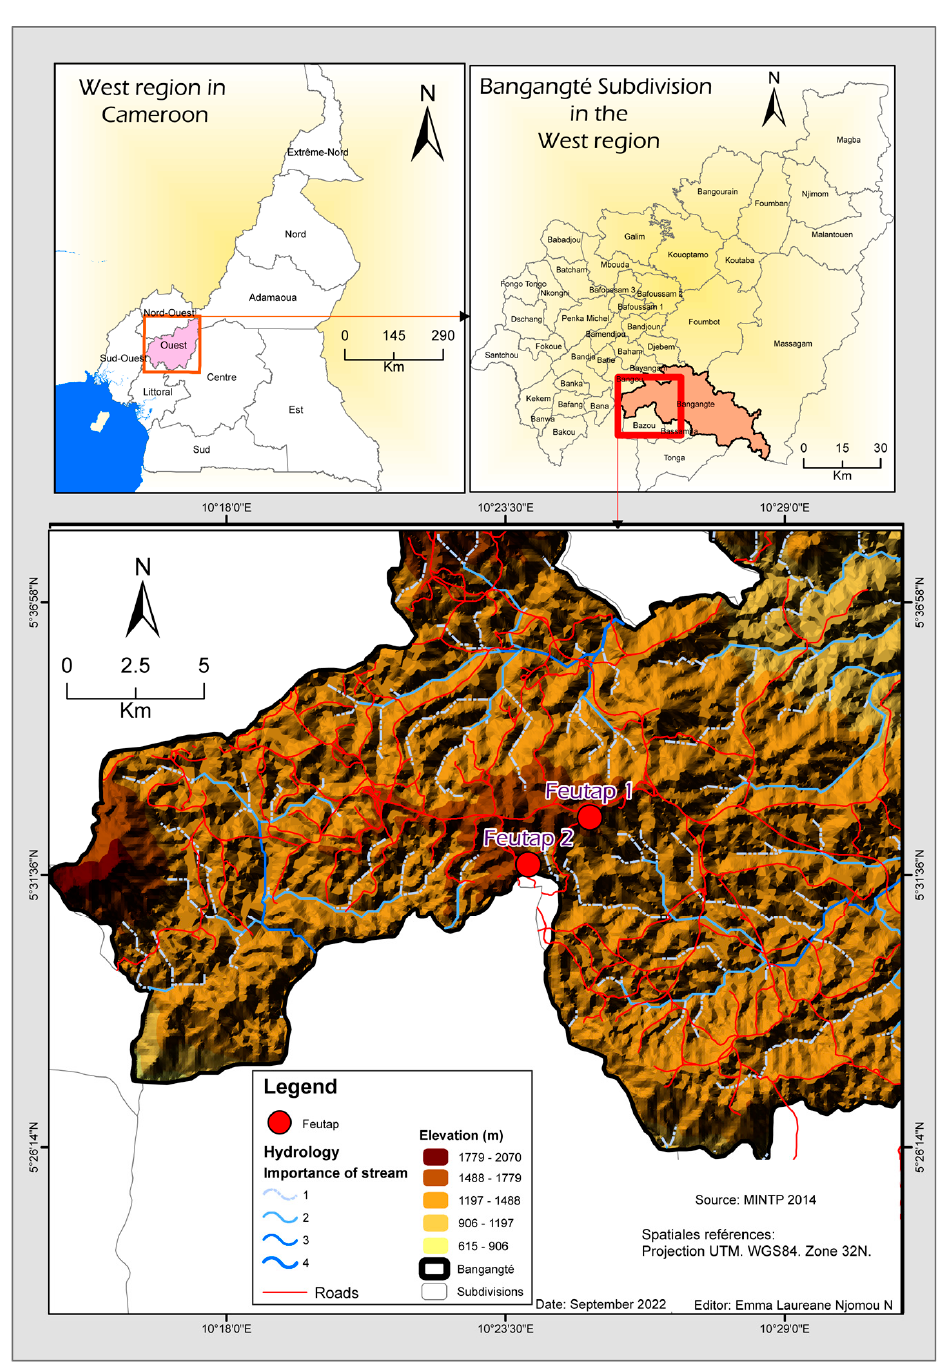
Figure 1. The location of Feutap in Bangangt é . The hydrological and drainage network clearly shows that there is no river in